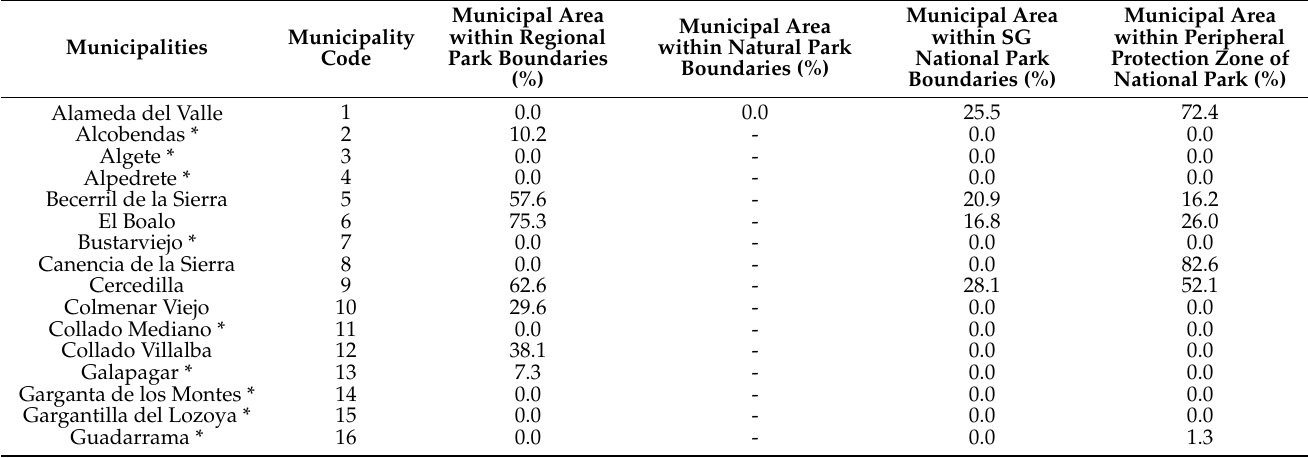
Table A1. Municipalities of the study area inside of and outside of the protected area network: “Cuenca Alta de Manzanares Regional Park”, “Cumbre, Circo and Lagunas de Peñalara Natural Park”, and “Sierra de Guadarrama National Park”.